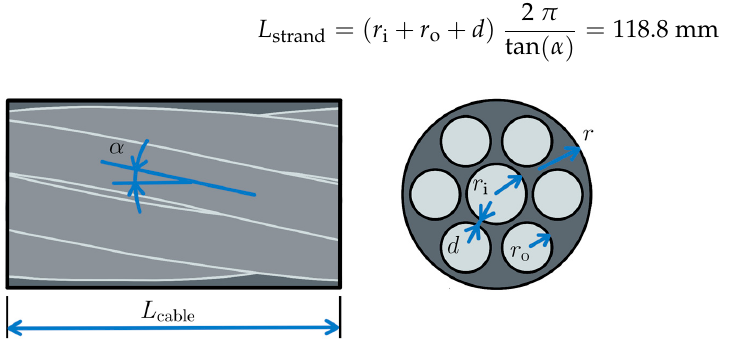
Figure 4. The geometry of the full ‐ geometry single ‐ cable model with its key parameters. Table 1. Geometric parameters of the seven-wire strand.